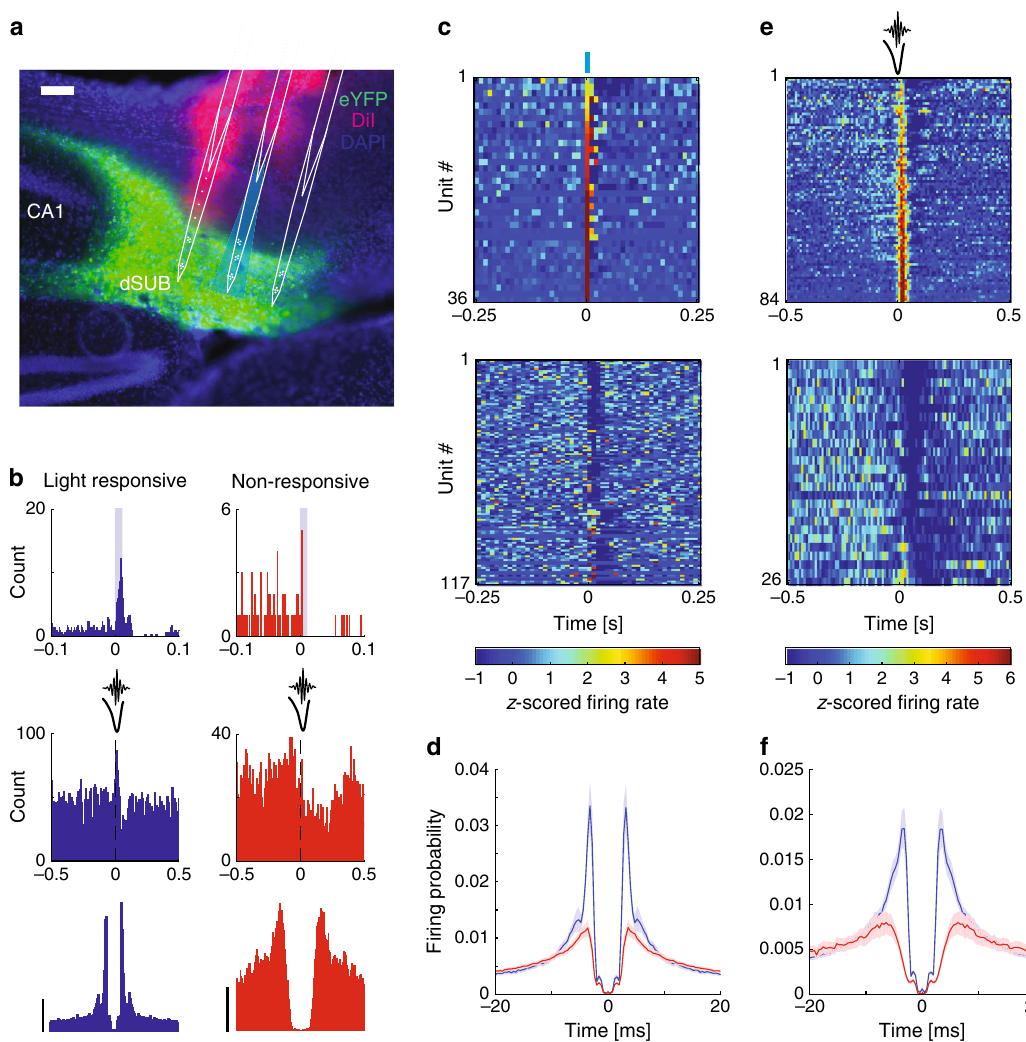
Fig. 8 Identi fi cation of subicular bursting cells in vivo. a Subicular bursting cells were labeled with ChR2-eYFP (green) using the VGlut2-Cre mouse line. Probes were coated with a dye (DiI, magenta) to con fi rm subicular targeting. Scale bar, 100 µ m. b Examples of a light responsive (blue, top left) and a non- responsive (red, top right) subicular units, their responses to SPW-Rs (middle) and their ACGs (bottom). ACG range ± 25 ms; scale bar, 10 Hz. c Z-score normalized PETHs showing the responses of all units, which are positively (top) modulated or not positively modulated (bottom) within the 10 ms blue light stimulation (blue bar at 0 s, n = 6 sessions from three mice). d Average ACGs of light responsive (blue) and non-positively responsive (red) units. e Z-score normalized PETHs showing the responses of all the units, which are positively (top) or negatively modulated (bottom) by SPW-Rs ( n = 6 sessions from three mice). f Average ACGs of positively (blue) and negatively (red) modulated